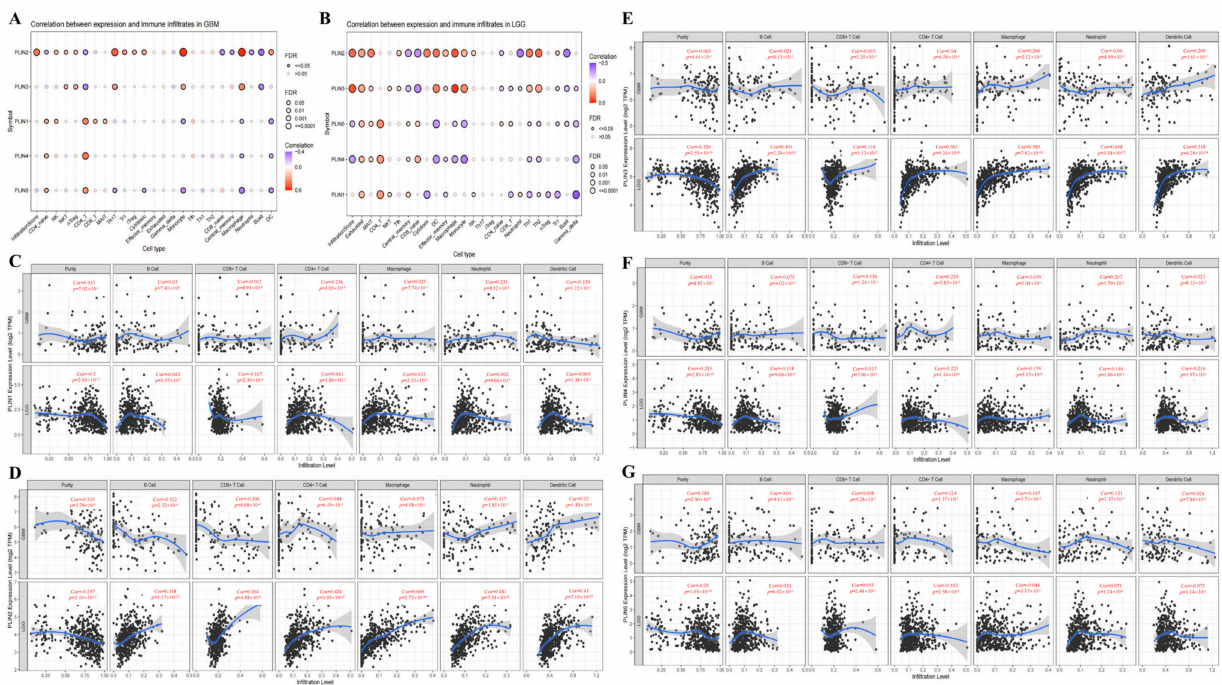
Figure 7. Correlation analysis of PLINs family and immune microenvironment of glioma tumors. ( A , B ) The overall relationship between PLINs and tumor immune cells was analyzed through the GSCA online website. ( C – G ) Correlation analysis of PLIN1 − 5 with tumor immune cells in LGG and